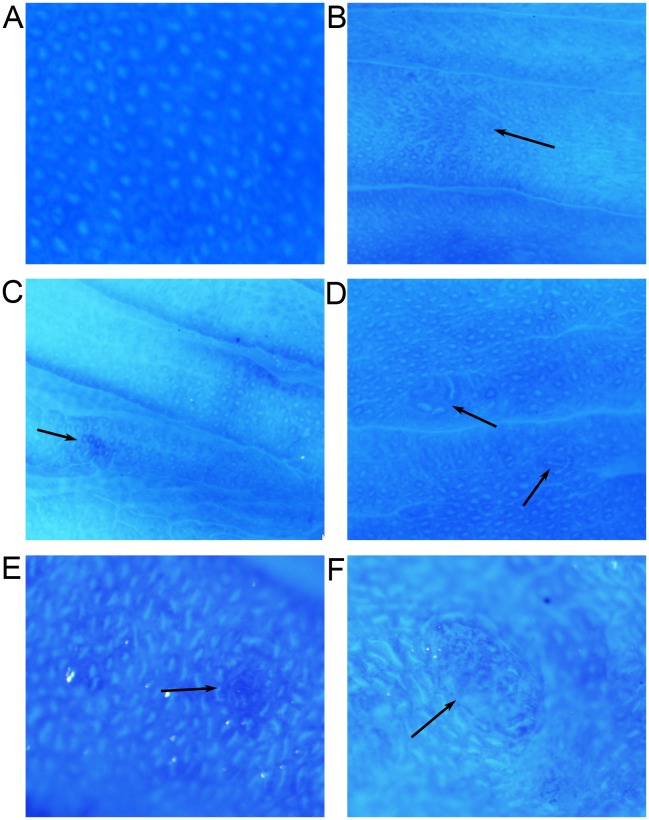
Formation of ACF induced by DMH in the rat colon.Fig. 3A: normal crypt foci (100×). Fig. 3B: Crypt enlargement and deformation (40×). Fig. 3C: ACF formed by 2 aberrant crypts (40×). Fig. 3D: ACF formed by 3 aberrant crypts (40×). Fig. 3E: ACF formed by ≥3 aberrant crypts (40×). Fig. 3F: tumor-like tissue (40×).